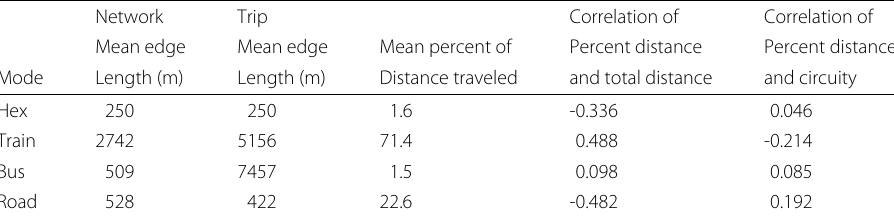
Table 7 Characteristics of the trip data related to mode usage, total distance, and